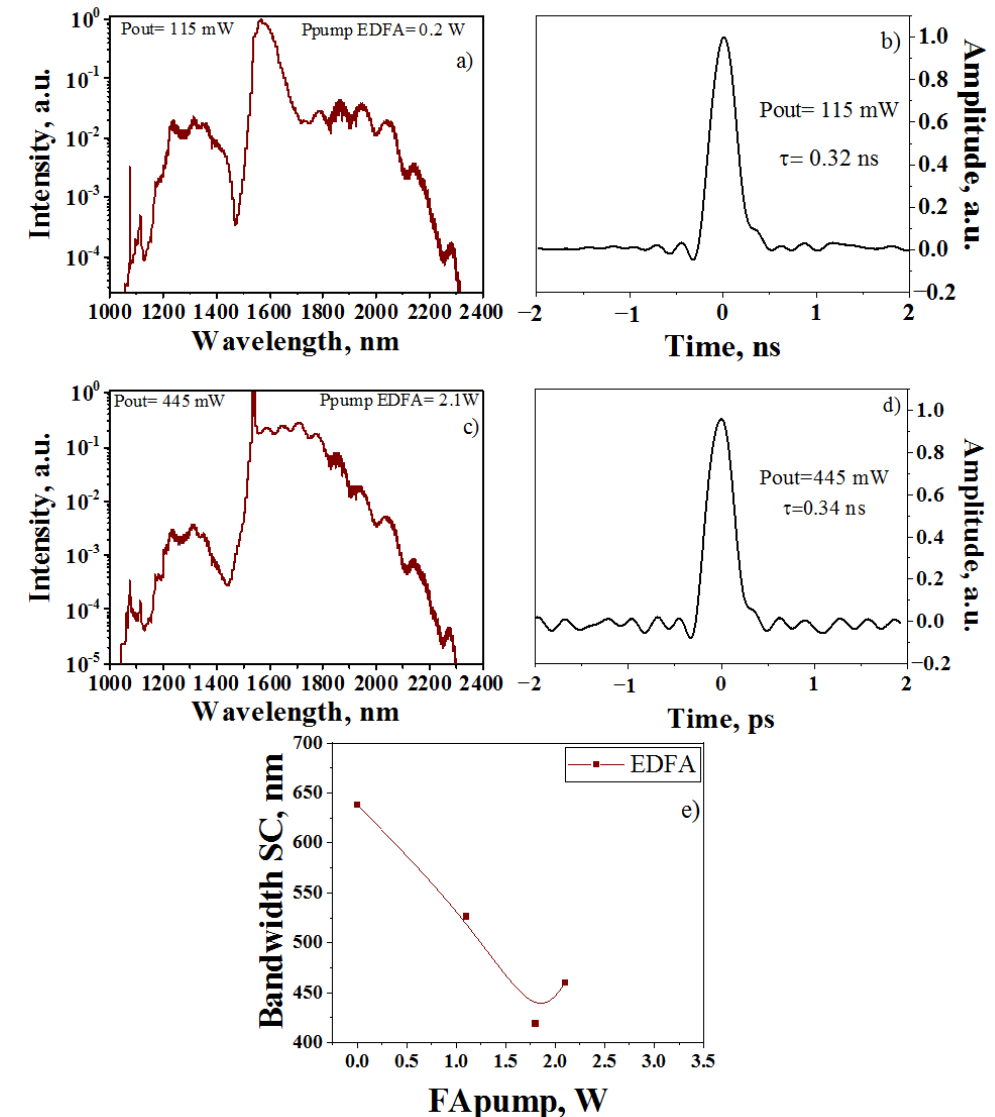
Figure 3. Spectral ( a , c ) and temporal ( b , d ) characteristics of radiation after Er-doped FA at lower (top row) and higher (bottom row) pump power and graph of SC bandwidth vs. pump power ( e ).